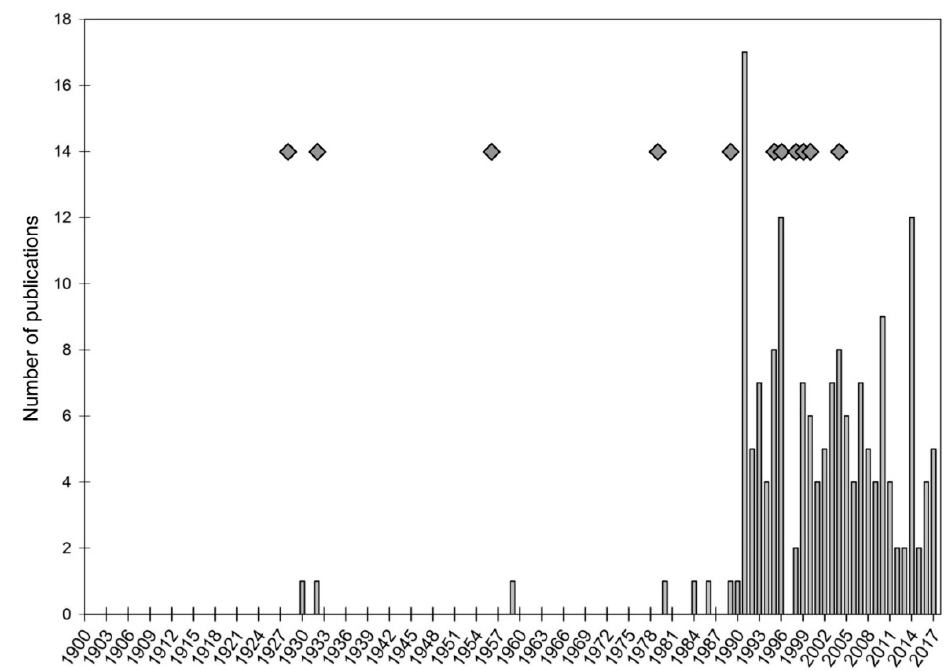
Figure 2. Number of publications per year obtained from the systematic literature review with hurricanes and storms identified (rhombus symbol).